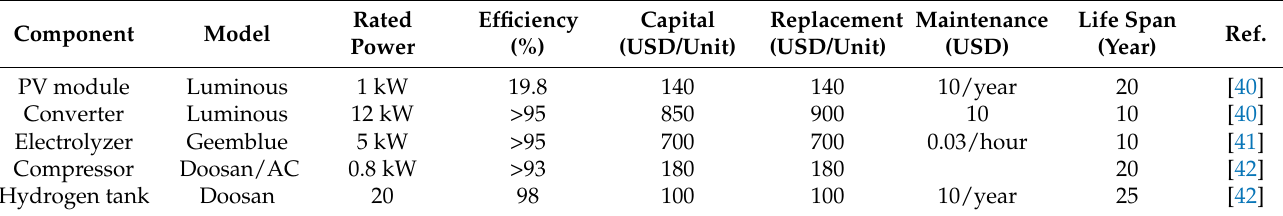
Figure 2. Schematic of the proposed system to produce hydrogen using solar energy. Table 1. The technical and economic specifications.